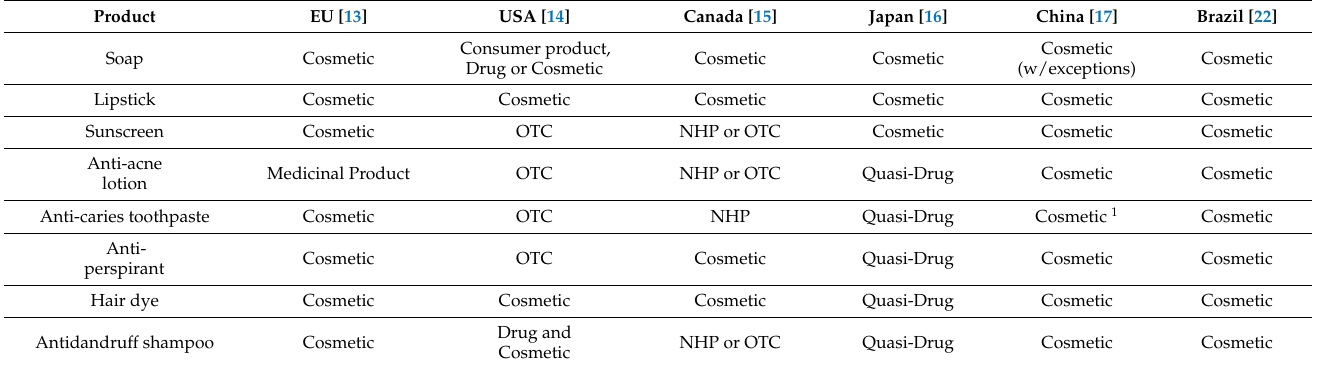
Table 4. Examples of product categorization in the six regions (EU, USA, Canada, Japan, China and